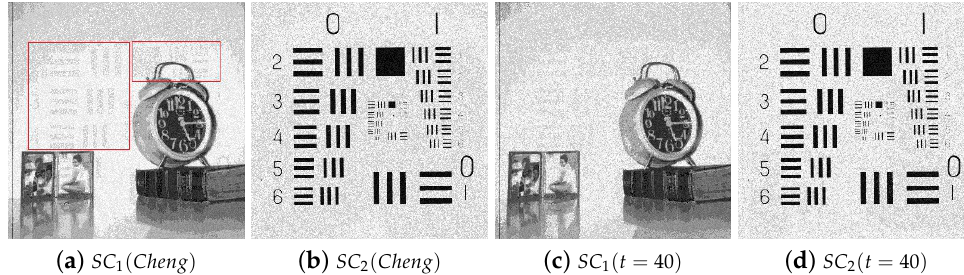
Figure 5. (2,2) threshold experimental comparison results of Cheng et al. and the proposed scheme; ( a , b ) results of Cheng’s scheme; ( c , d ) results of the proposed scheme with t =